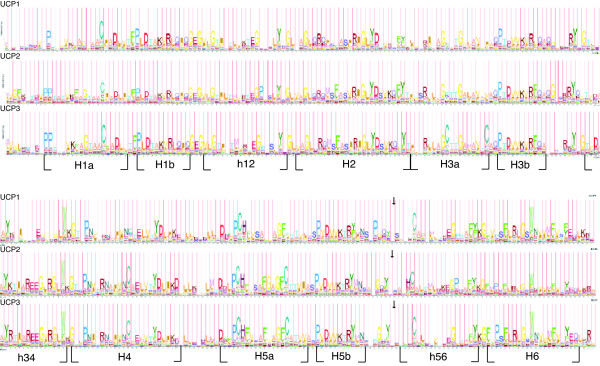
HMM Logos for UCP1, UCP2 and UCP3. Comparison of the HMM Logos of UCP1, UCP2 and UCP3 protein alignments (excluding variable regions). The numbering of each α-helix follows the nomenclature used for the ADP/ATP carrier [55]. The site under positive selection in model M8 is indicated with an arrow.